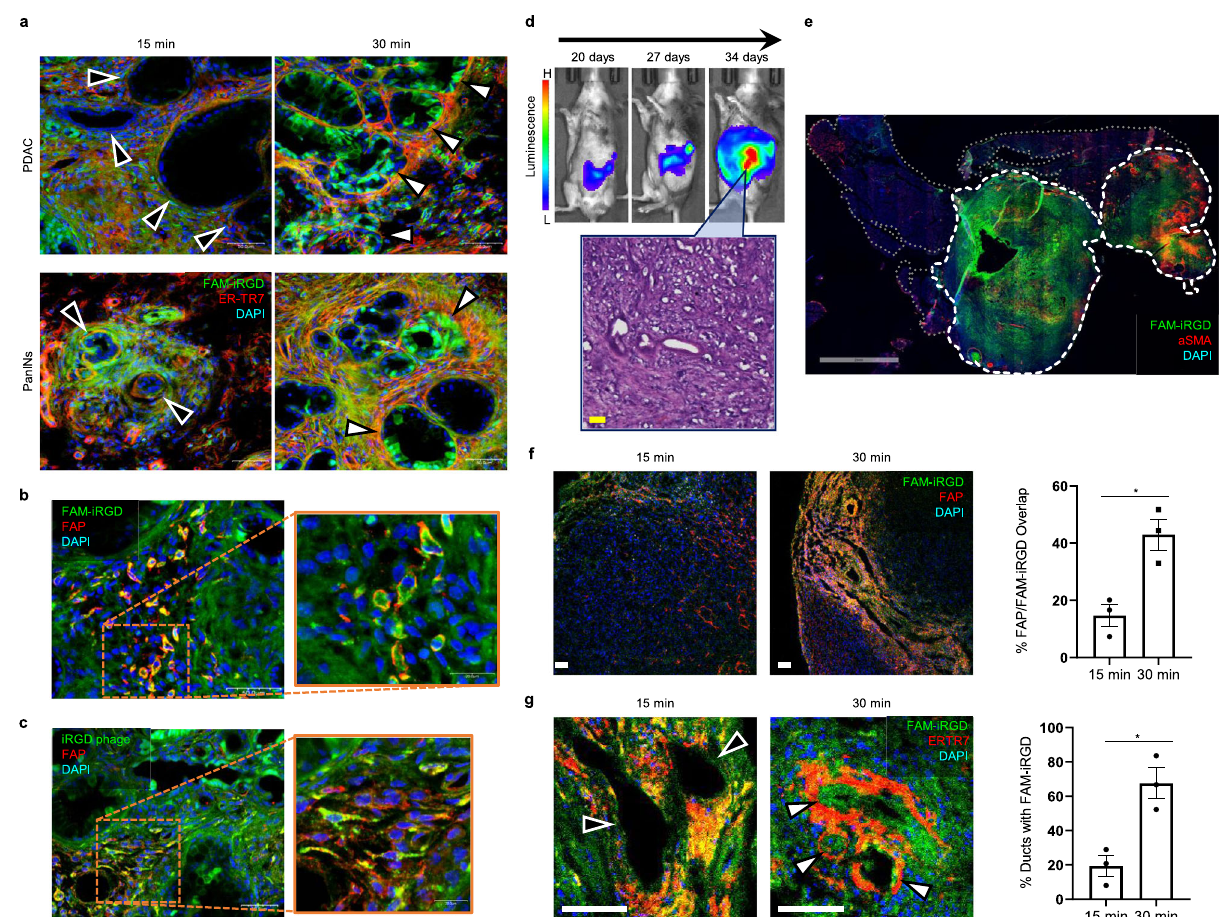
Fig. 1 iRGD penetrates desmoplastic PDAC. a – c FAM-iRGD or iRGD-displaying T7 phage was intravenously injected into transgenic p48-CRE , LSL- Kras G12D , INK4a fl ox mice that develop de novo PDAC. a FAM-iRGD (green) rapidly spreads through ER-TR7-positive stroma (red) in the fi rst 15 min, and start entering ductal structures in full blown PDAC and PanINs in 30 min. Scale bars, 50 µ m. b Fluorescent signals of FAM-iRGD (green) in FAP-positive CAFs (red) after 30 min. c iRGD phage (green) penetrated into the PDAC and colocalized with FAP-positive CAFs (red). Scale bars ( b and c ), 50 or 20 µ m (magni fi ed views). d Longitudinal luminescence imaging of orthotopic PDAC generated with KPC-derived organoids. The organoids were pre-labeled